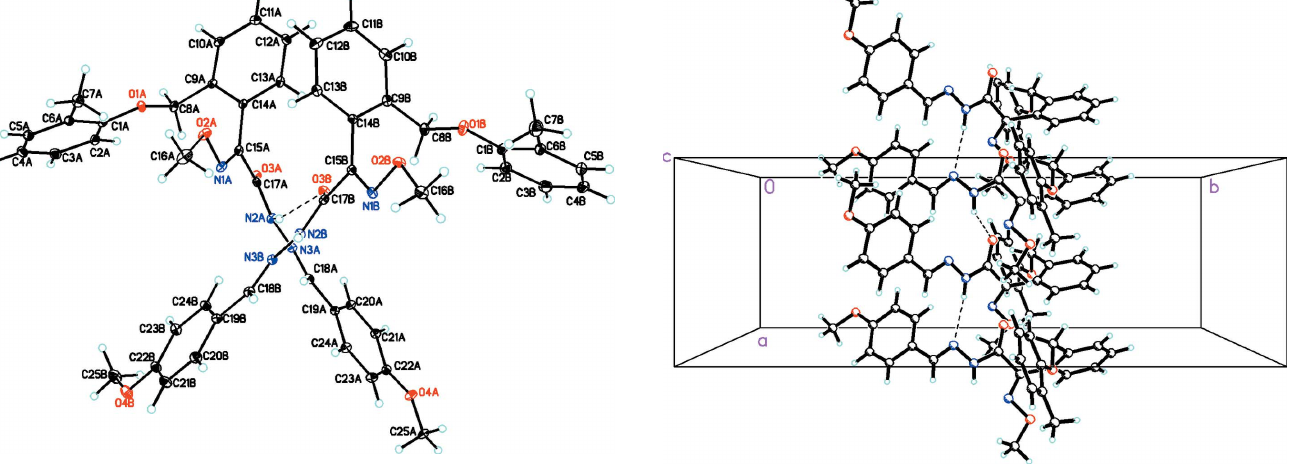
Figure 1 The molecular structure of the two independent molecules of the title compound with hydrogen bonds shown as dashed lines. Atomic displacement parameters are at the 30% probability